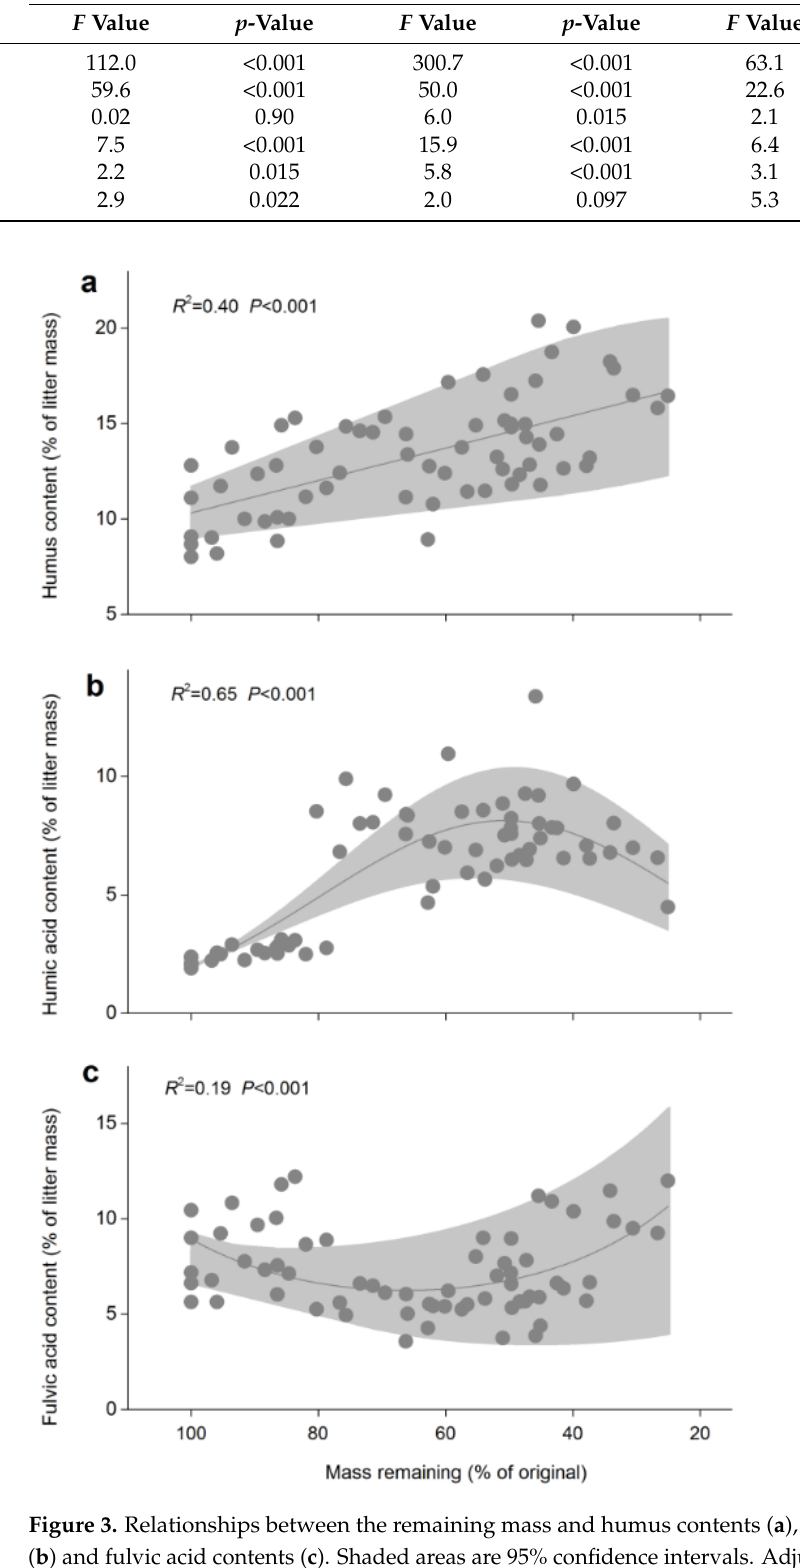
Figure 3. Relationships between the remaining mass and humus contents ( a ), humuc acid contents ( b ) and fulvic acid contents ( c ). Shaded areas are 95% confidence intervals. Adjusted R 2 and p -values from linear or exponential regressions are shown in each panel (all n = 78).